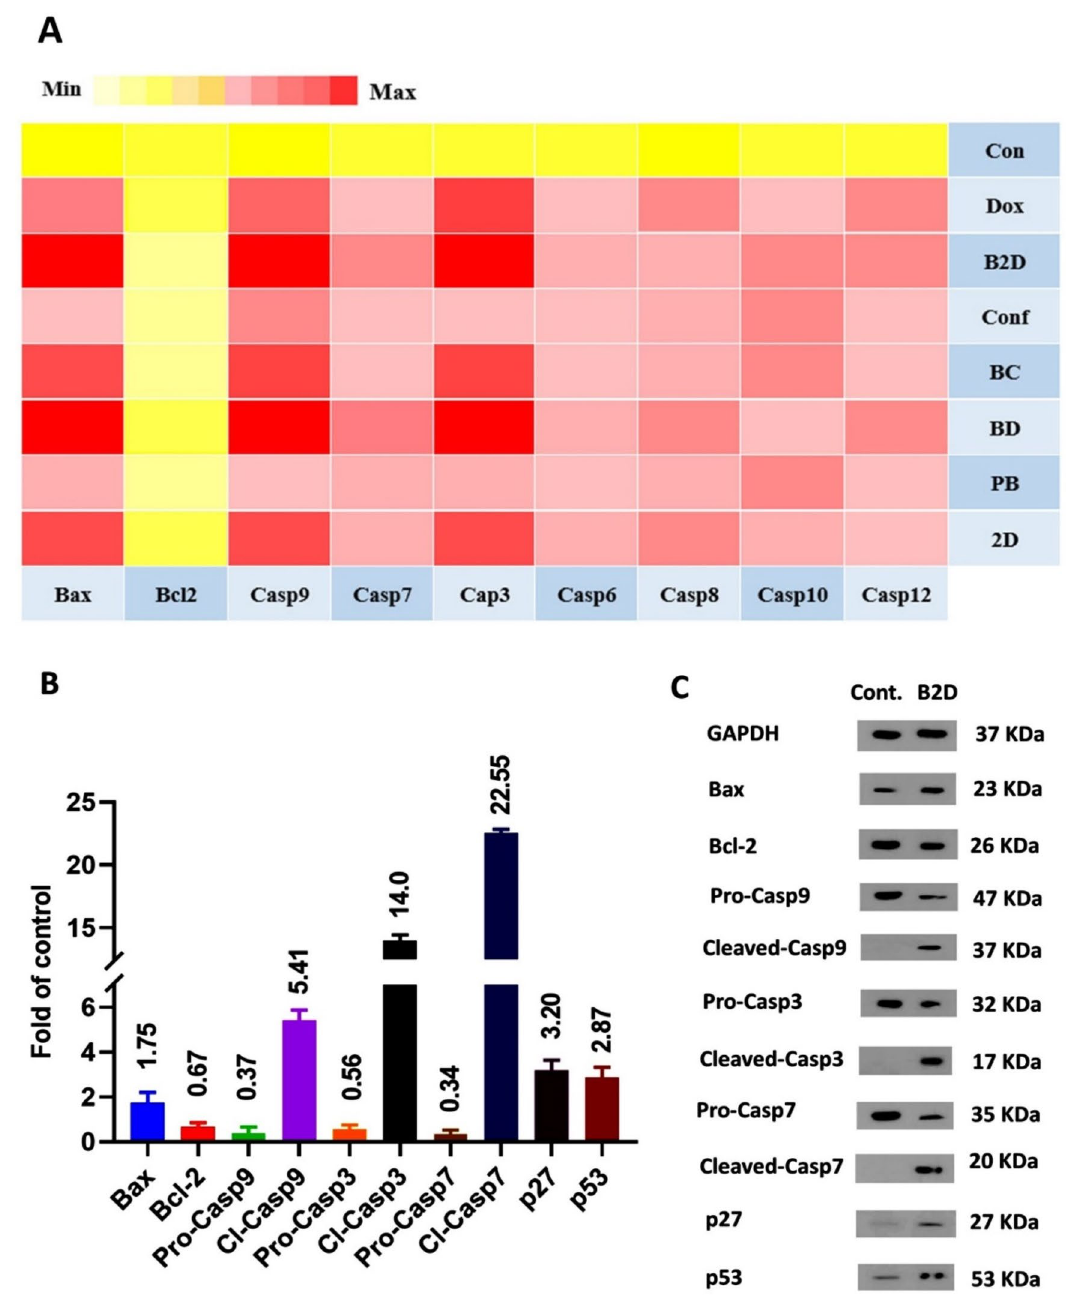
Figure 8. ( A ) Results of real-time PCR analysis of MDA-MB-231 cells treated with all formulations (0.259 μg/ mL of B2D , 2D , BD , Dox , BC and Conf and 2.59 μg/mL of PB ) as the heat map of expression level of genes related to un-treated control group (gene expresion = 1). The yellow and light-yellow colors are the signs of lack of gene expression or downregulation of it and red color shows upregulation of gene expression related to the control (genes: Bcl-2, Bax, Caspase-3, Caspase-6, Caspase-7, Caspase-8, Caspase-9, Caspase-10, Caspase-12 and GAPDH as the internal control gene); ( B ) Diagram of proteins expression changes related to the control group (protein expression = 1) obtained from western blotting (the MDA-MB-231 cells were treated by B2D with concentration of 0.259 μg/mL). Proteins: Bcl-2, Bax, pro-Caspase-9, Cleaved-Caspase-9, pro-Caspase-3, Cleaved-Caspase-3, pro-Caspase-7, Cleaved-Caspase-7, p27 and p53, and GAPDH as internal control, n = 2; ( C ) Images of western blotting of the MDA-MB-231 cells treated with B2D (0.259 μg/mL). Un-treated cells were considered as the control group. (Abbreviations: PB : blank βCD-g-PMA-co-PLGA micelles, B2D : co-drug loaded βCD-g-PMA-co-PLGA micelles, BD : Dox loaded βCD-g-PMA-co-PLGA micelles, BC : Conferone loaded βCD-g-PMA-co-PLGA micelles, Dox : Free Doxorubicin, Conf : Free Conferone, 2D : Free Doxorubicin-